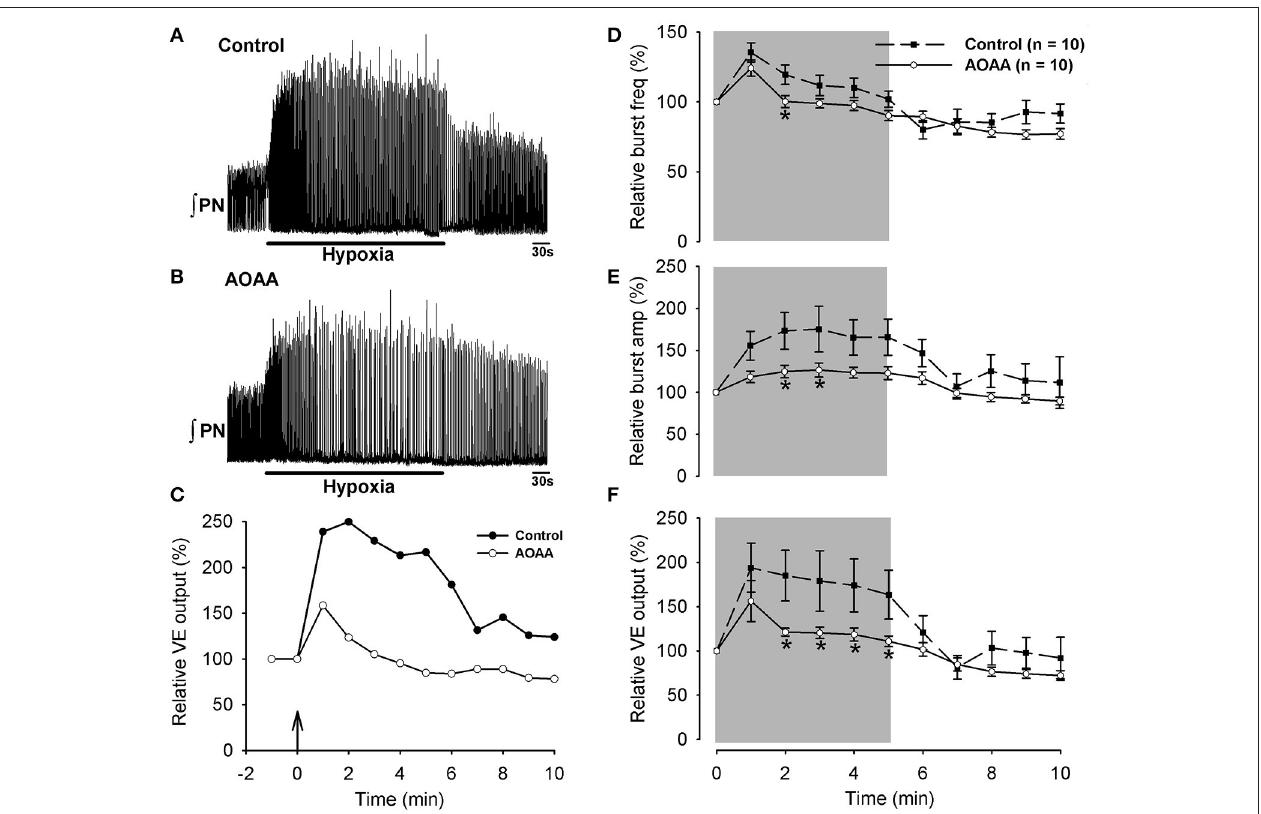
FIGURE 5 | Representative recordings of phrenic nerve activity showing the response of an anesthetized rat to hypoxia (10% O 2 , Balance N 2 , for 5min) in control (A) and again one h later after unilateral injection of AOAA into the preBötC (B) . The time course of ventilatory output calculated from the corresponding control (A) and AOAA traces (B) are shown in (C) . Black arrow indicates the beginning of hypoxia (C) . Group data showing the time course of the ventilatory response to hypoxia in control trials ( n = 10) and after injection of AOAA (1mM, 250nL, n = 10) into the preBötC. Inspiratory frequency (D) , burst amplitude (E) and ventilatory output (F) are shown. *indicates difference ( p < 0.05) compared to control.